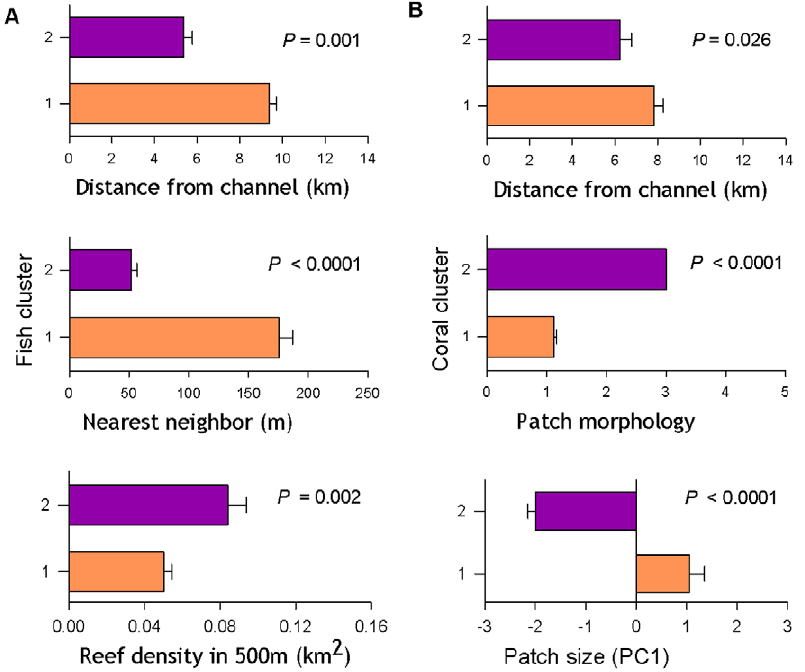
Figure 2. Seascape attributes by patch reef site groups. Attributes of (A) fish and (B) coral site groups for each key seascape metric. Group 1 attributes are in purple; group 2 in orange. One-factor ANOVA significance values for each metric are shown.